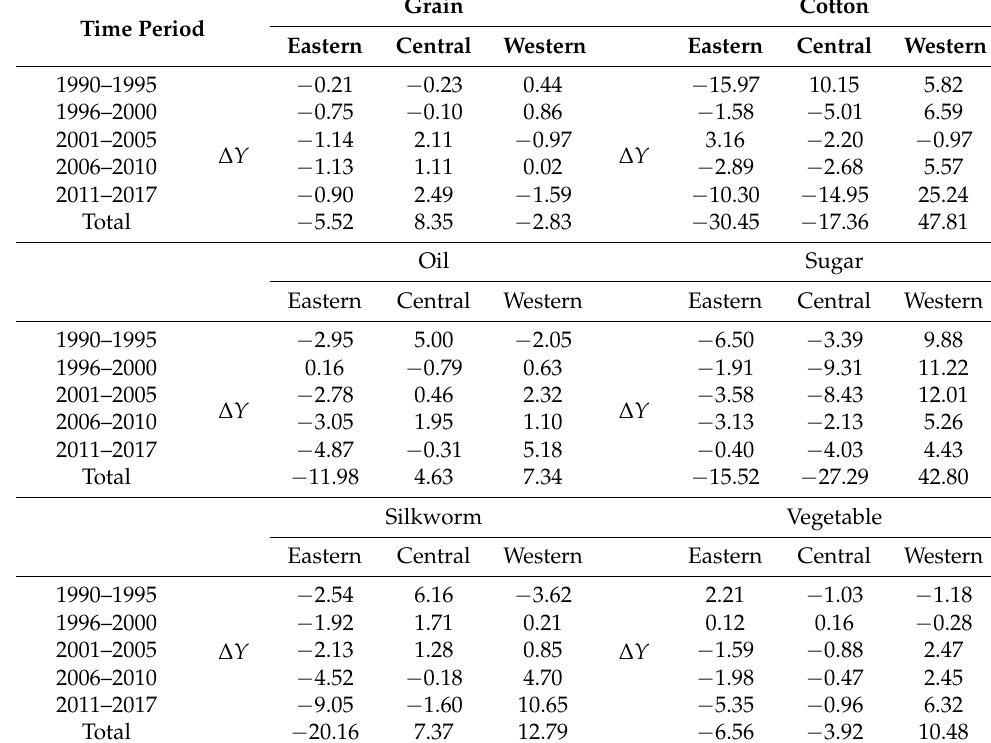
Table 2. The production location adjustment of different crops in China